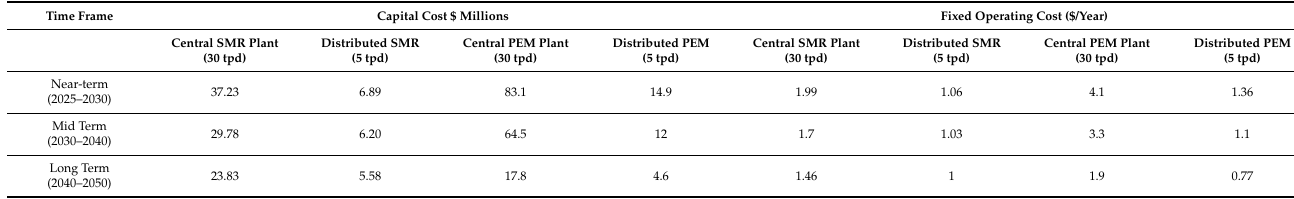
Table 3. Capital and operating cost assumptions.